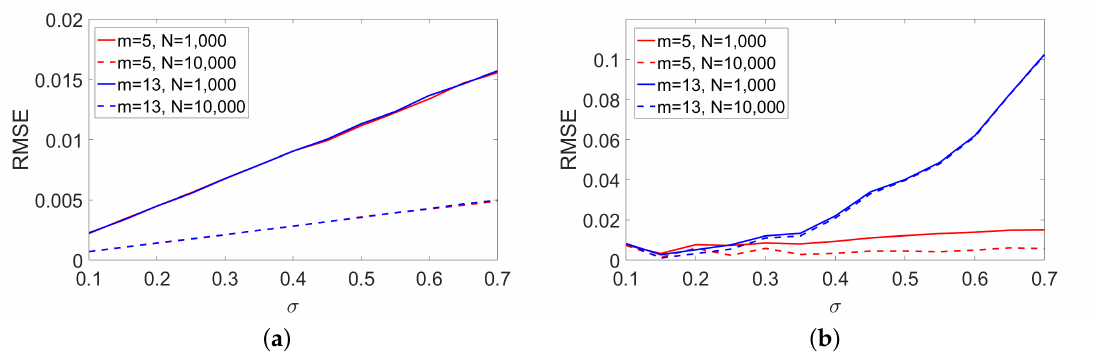
Figure 5. Root mean square error of the dispersion parameter for Gaussian models based on ( a ) the LE and ( b ) affine invariant Riemannian metrics.